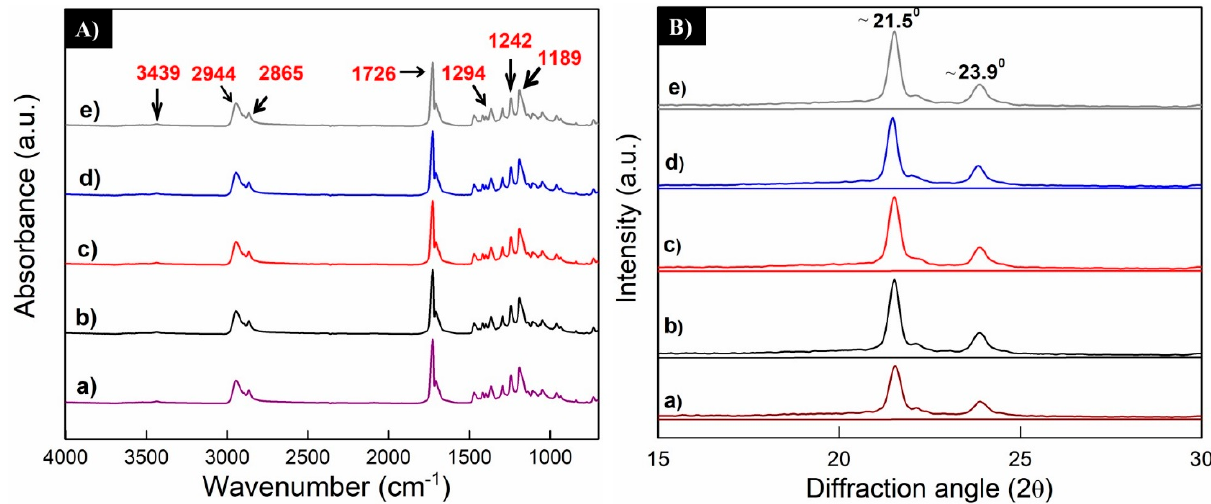
Figure 6 . ( A ) FTIR-ATR spectra (left-side) and ( B ) diffractrograms (right-side) of electrospun PCL nanofibers obtained at different voltages: ( a ) pellet (raw material), ( b ) 10 kV, ( c ) 15 kV, ( d ) 20 kV, and ( e ) 25 kV.